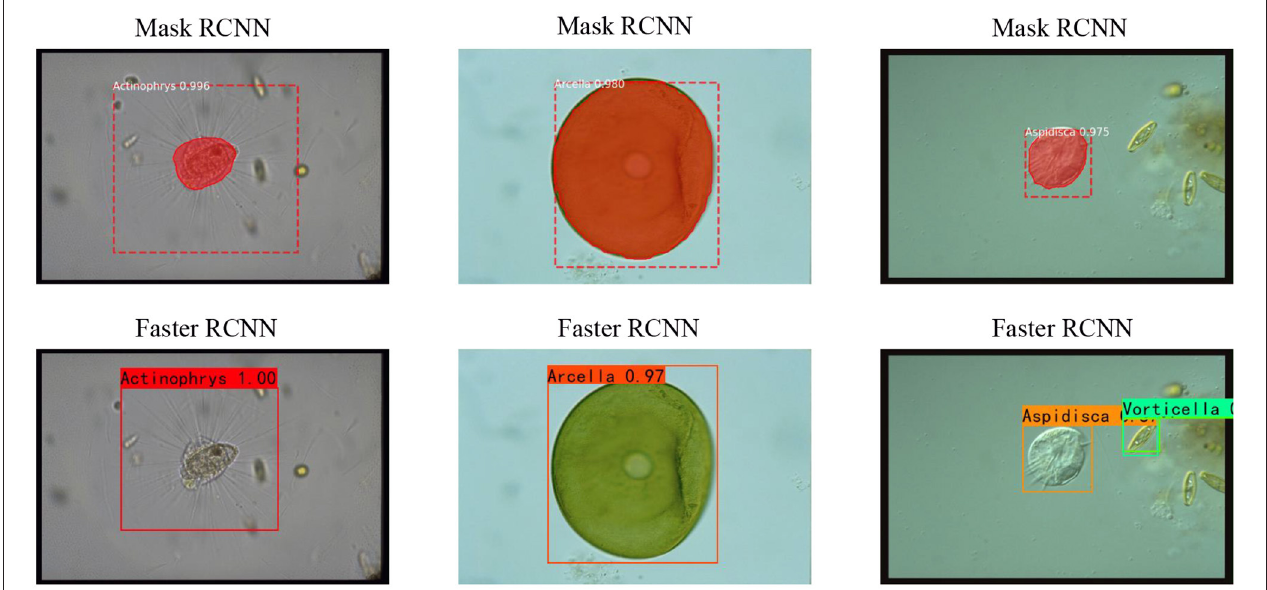
FIGURE 4 | Faster RCNN and Mask RCNN object detection results.